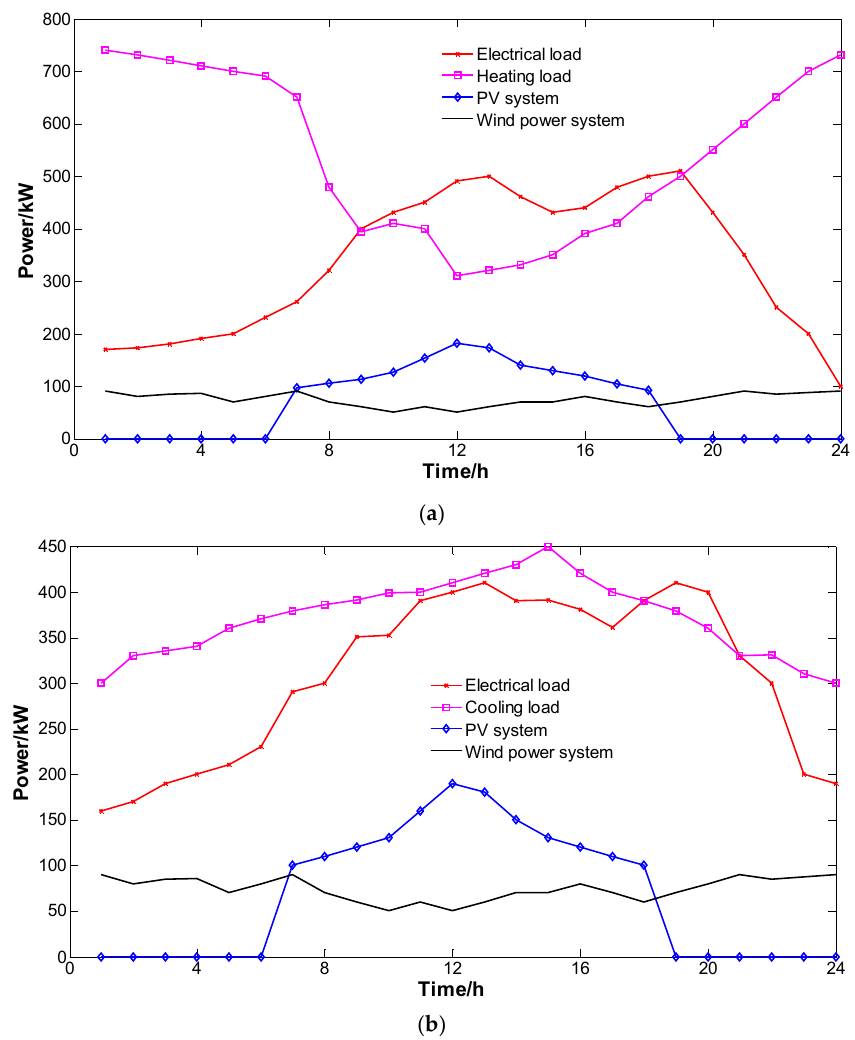
Figure 8. Cooling, heating, and electrical load curves, and wind power and photovoltaic (PV) prediction curves for the micro-energy grid on a typical day in the winter ( a ), and in the summer ( b ).